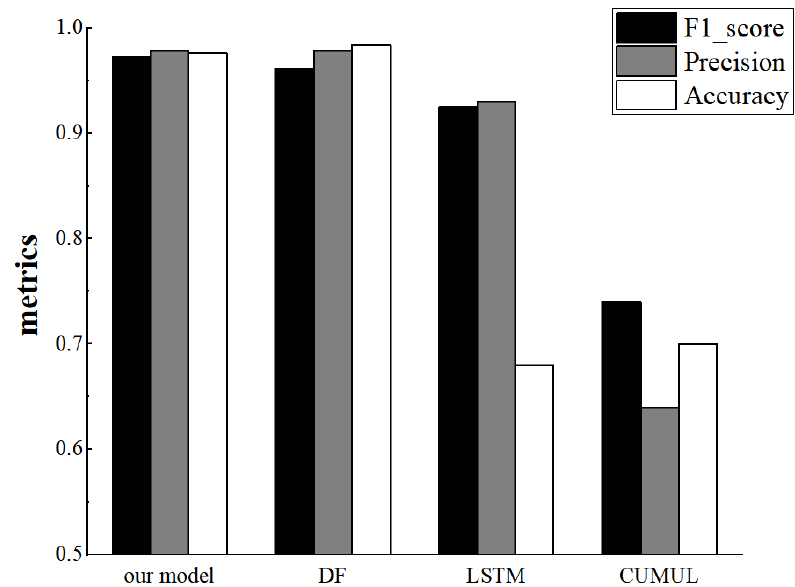
Figure 17. F1_score, precision and accuracy on different models in the open-world setting.